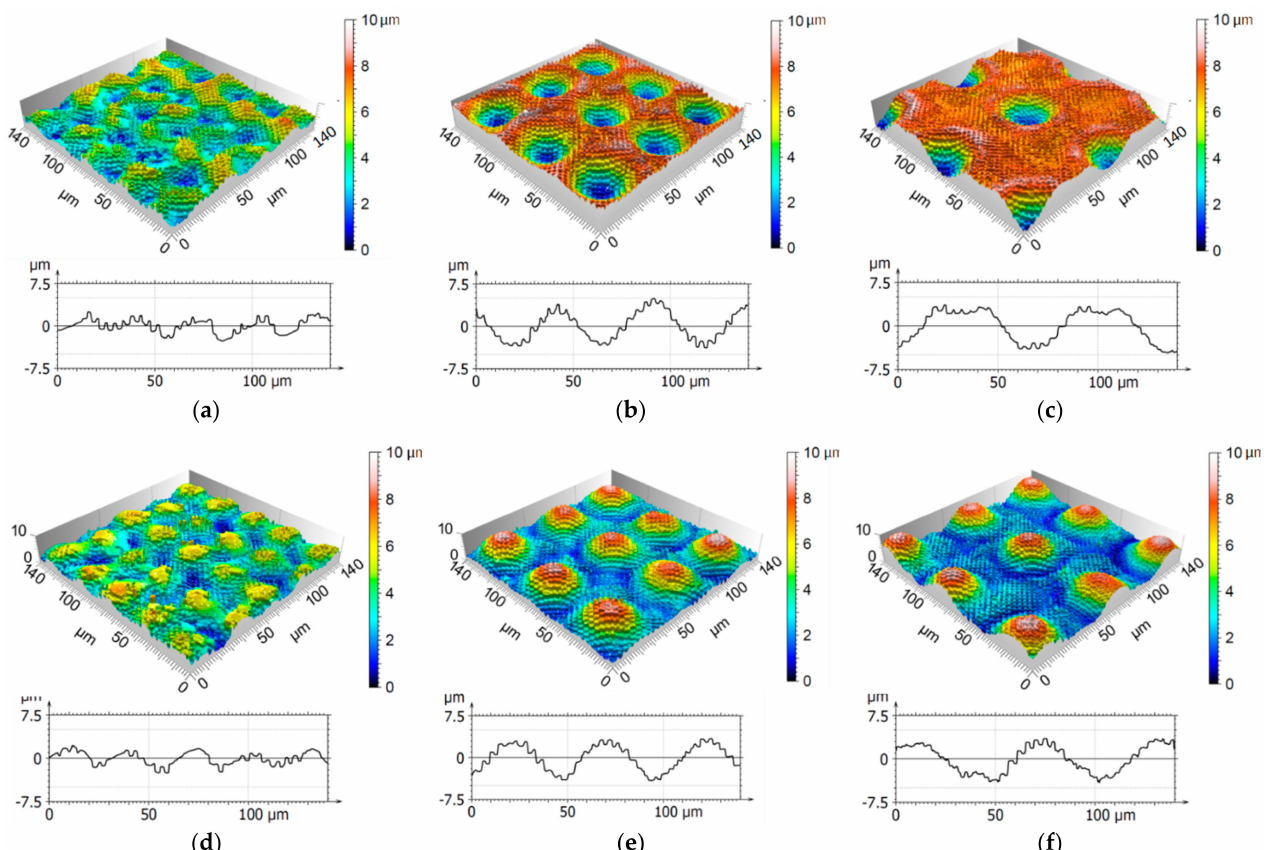
Figure 9. Confocal images and extracted profiles of hierarchical microstructures on stainless steel ( a – c ) and a hot embossed PET foil ( d – f ). Distance between spots was ( a , d ) 30 µ m, ( b , e ) 50 µ m, and ( c , f ) 70 µ m. Profiles were extracted with a length of 140 µ m at a range of 15 µ